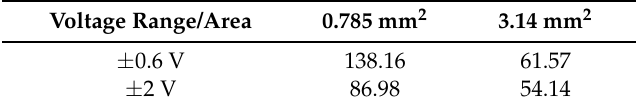
Table 1. Calculated charge storage capacity (mC/cm 2 ) under different conditions.